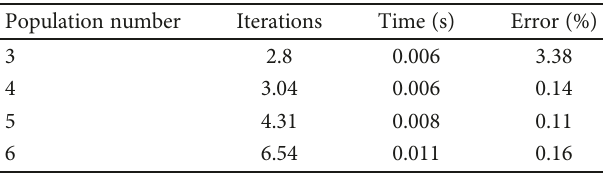
Table 5: Simulation results of the proposed algorithm with di ff erent population numbers under uniform irradiance.